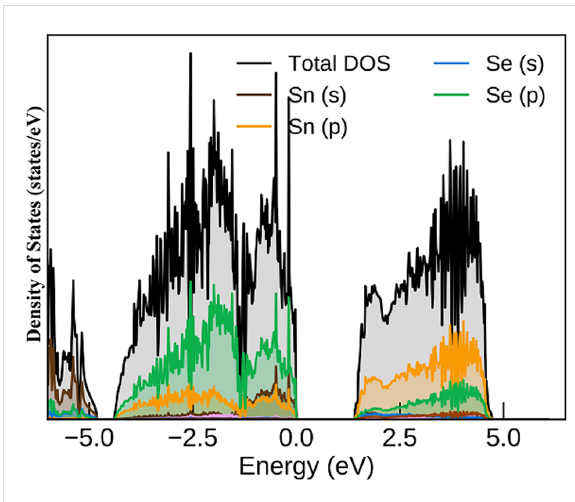
Figure 3: Density of states plot for the π -SnSe alloy calculated by the meta GGA-mBJ functional.